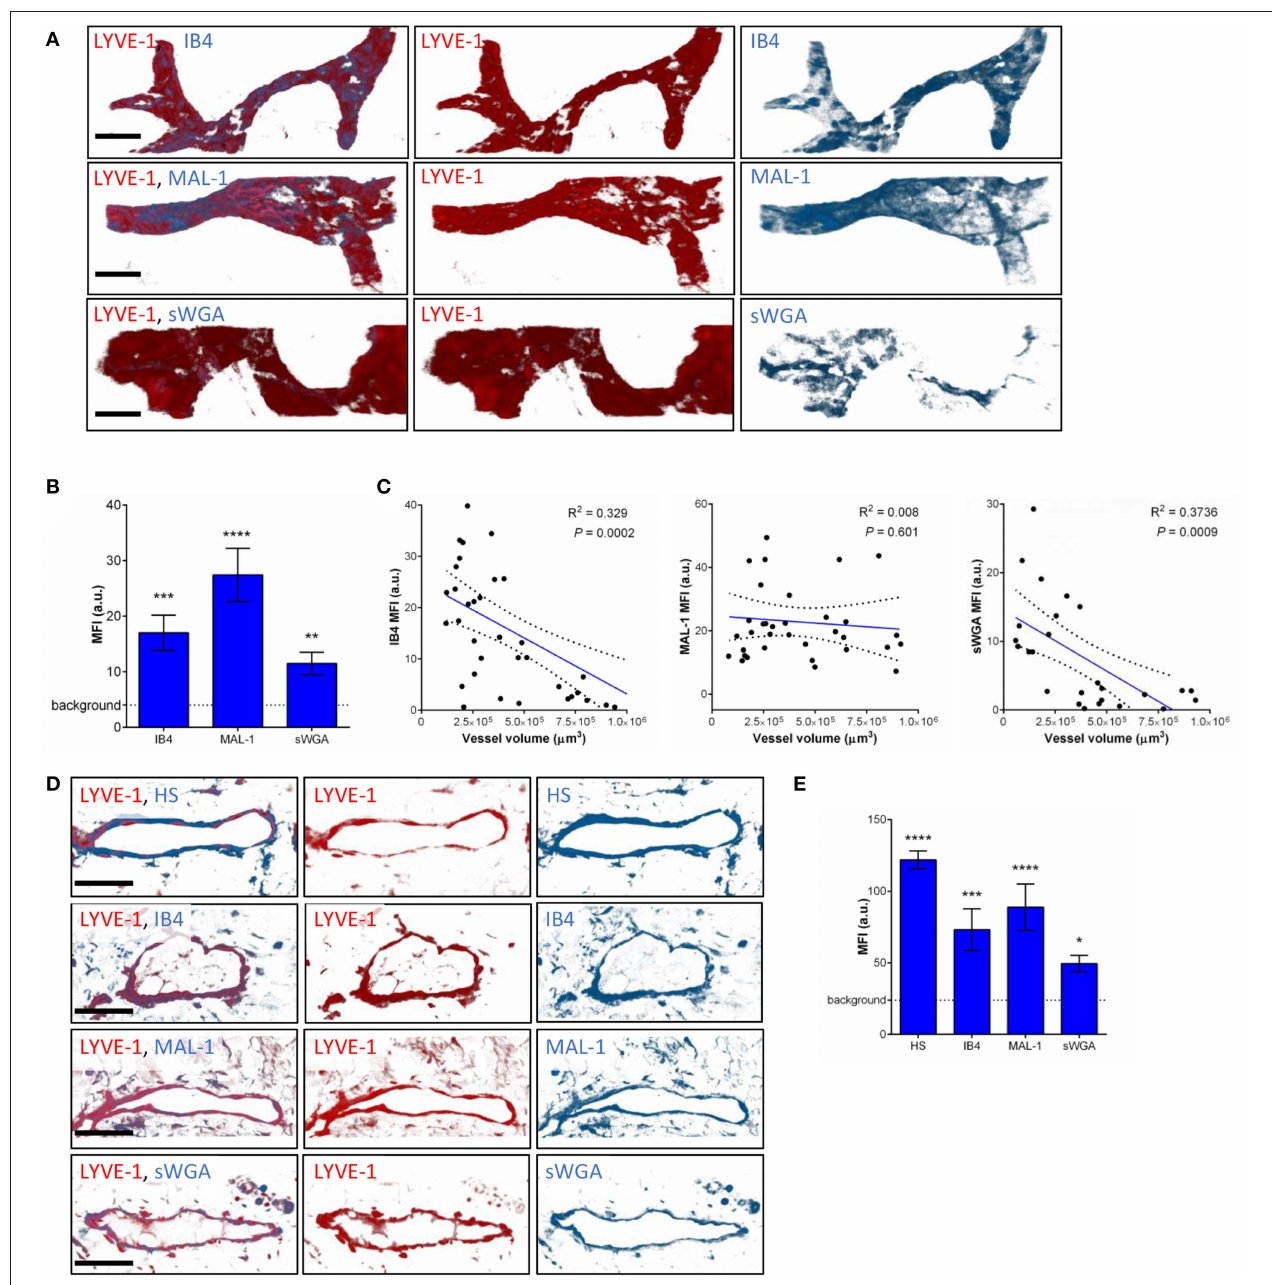
FIGURE 2 | Molecular composition of the glycocalyx on initial lymphatics of mouse and human skin. (A) The pictures are representative 3D-reconstructed confocal images of an initial lymphatic vessel (LYVE-1, red) segment from whole-mount fixed ears of naïve mice and fluorescently labeled with IB4, MAL-1 and sWGA lectins to visualize α -D-Galactosyl, sialic acid α 2,3-linked and N-Acetylglucosamine glycan moieties, respectively. (B) Quantification of the mean fluorescence intensity of IB4, MAL-1 and sWGA as quantified on initial lymphatic vessels of mouse ear skins. (C) The graphs show the linear relationship between the mean vessel size and the mean fluorescence intensity (MFI) of individual lectins (IB4, MAL-1, and sWGA). Each point represents an individual vessel from cremaster muscles. Dotted curved lines in the correlation plots represent 95% confidence interval. (D) The pictures are representative 3D-reconstructed confocal images of a lymphatic vessel (LYVE-1, red) from human breast skin sections and fluorescently labeled with anti-HS Ab, IB4, MAL-1, and sWGA lectins to visualize HS, α -D-Galactosyl, sialic acid α 2,3-linked and N-glucosamine glycan moieties, respectively. (E) Quantification of the mean fluorescence intensity (MFI) of anti-HS Ab, IB4, MAL-1, and sWGA as quantified on the lymphatic vessels of human skin samples. Bar = 50 µ m. Images are representative pictures from at least 8–10 vessels/sample, with at least 5 animals/4 human samples per group. Significant differences between lymphatic vessel MFI and background MFI are indicated by asterisks: * P < 0.05, ** P < 0.01, *** P < 0.001, **** P <